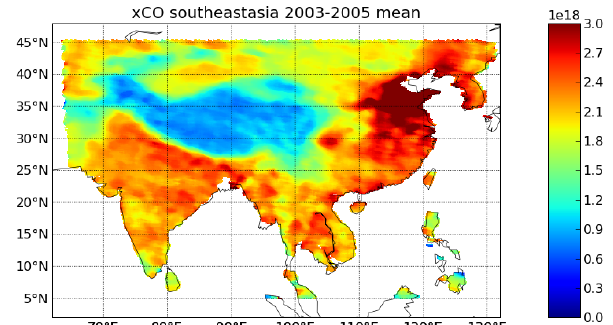
Fig. 19. Three-year average of CO vertical column densities [moleccm − 2 ] over South-East Asia. (0 . 2 ◦ × 0 . 2 ◦ grid with 1 ◦ × 1 ◦ median filter smoothing) Gloudemans et al., 2009) and the MOPITT mission (Clerbaux et al., 2008).